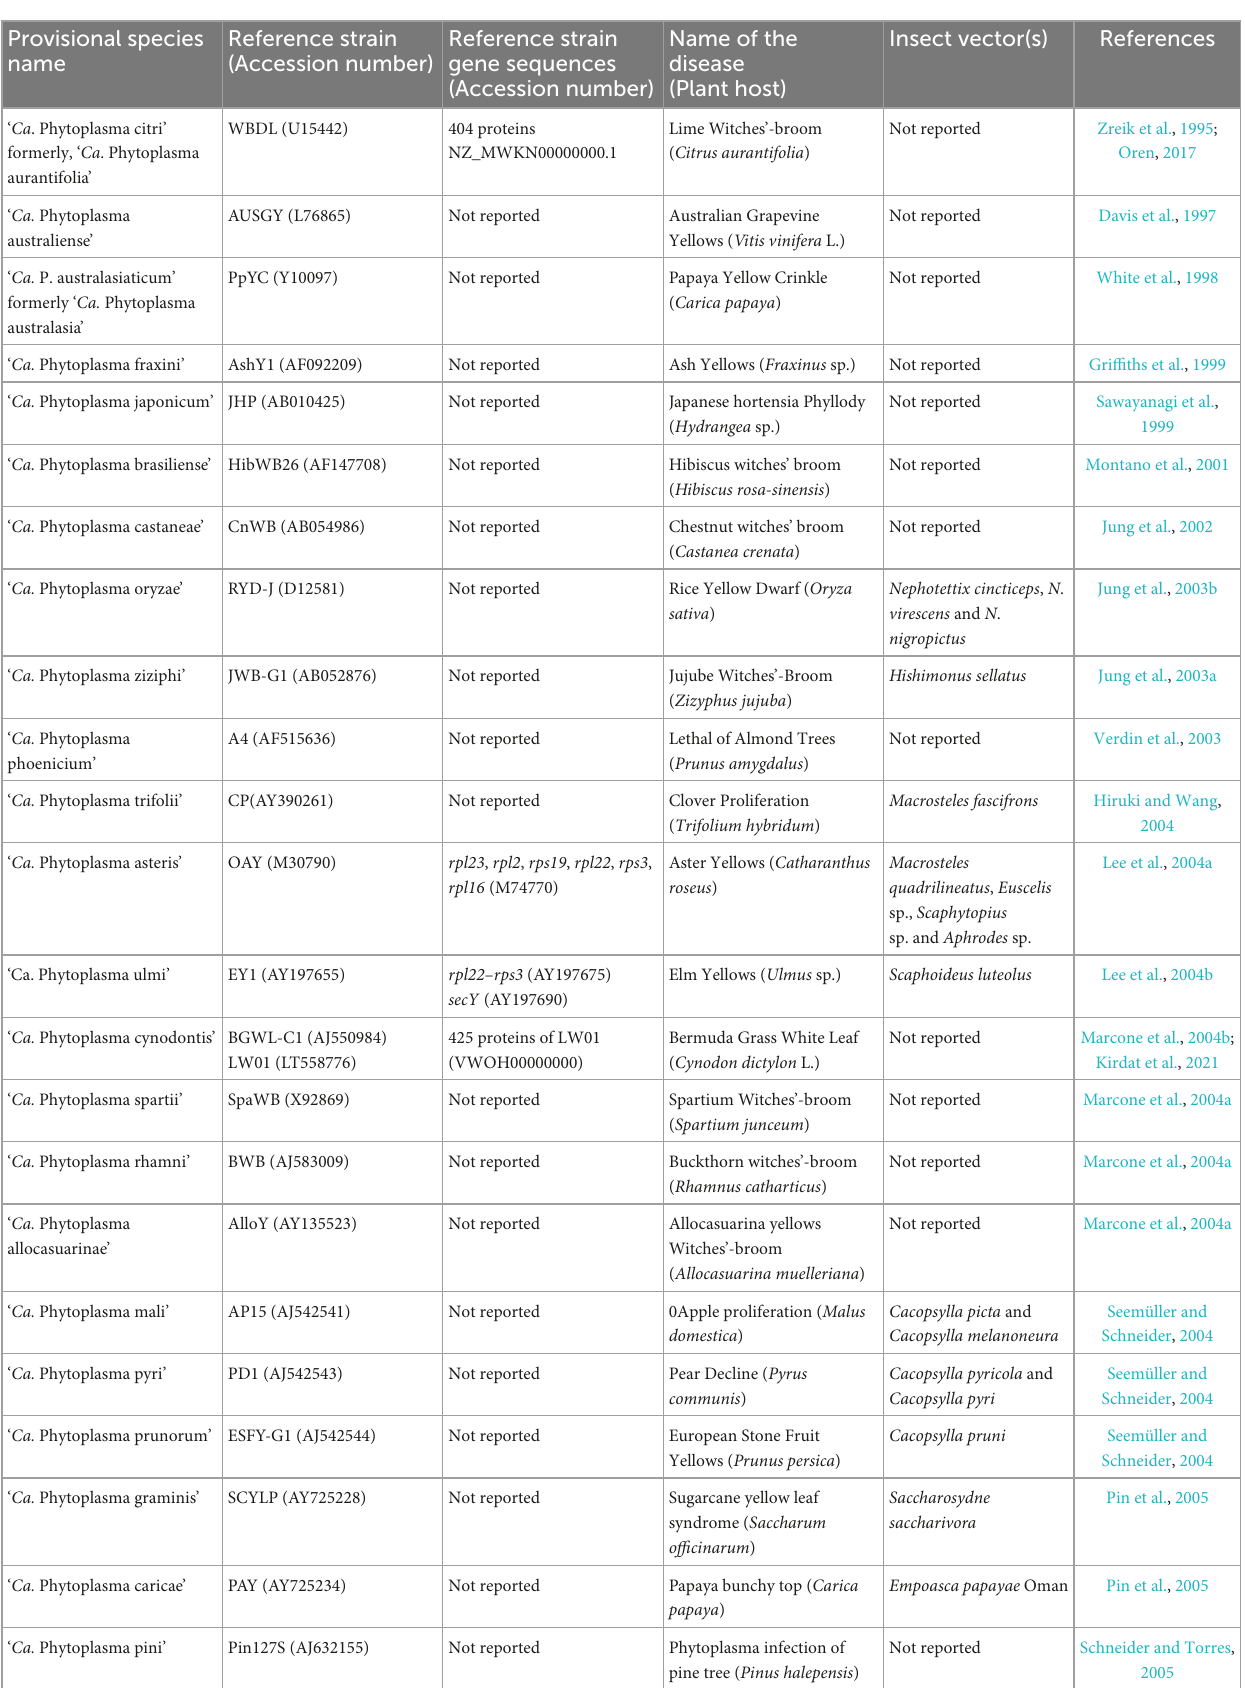
TABLE 1 List of provisional ‘Candidatus Phytoplasma’ species published as of December